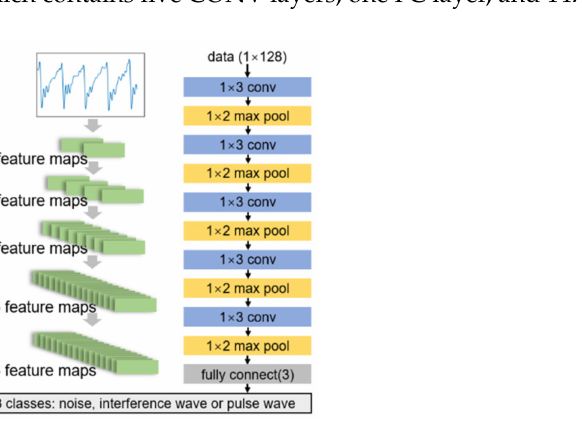
Figure 10. The CNN model has relatively high accuracy, shorter training time, and less